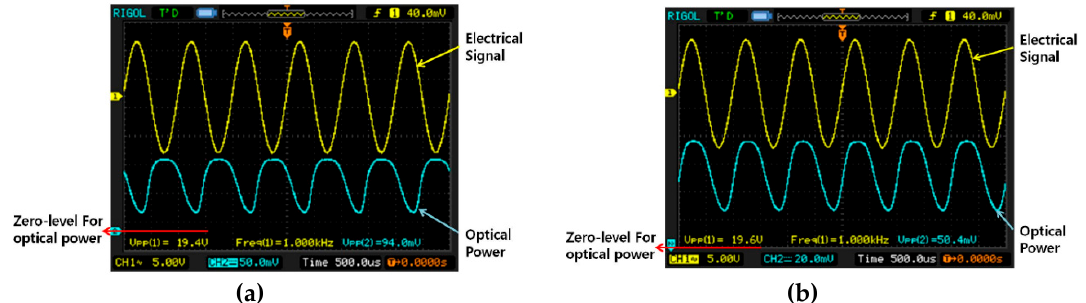
Figure 6. The 1 kHz ac modulation responses at the ( a ) upper and ( b ) lower output port, as shown in Figure 1a.